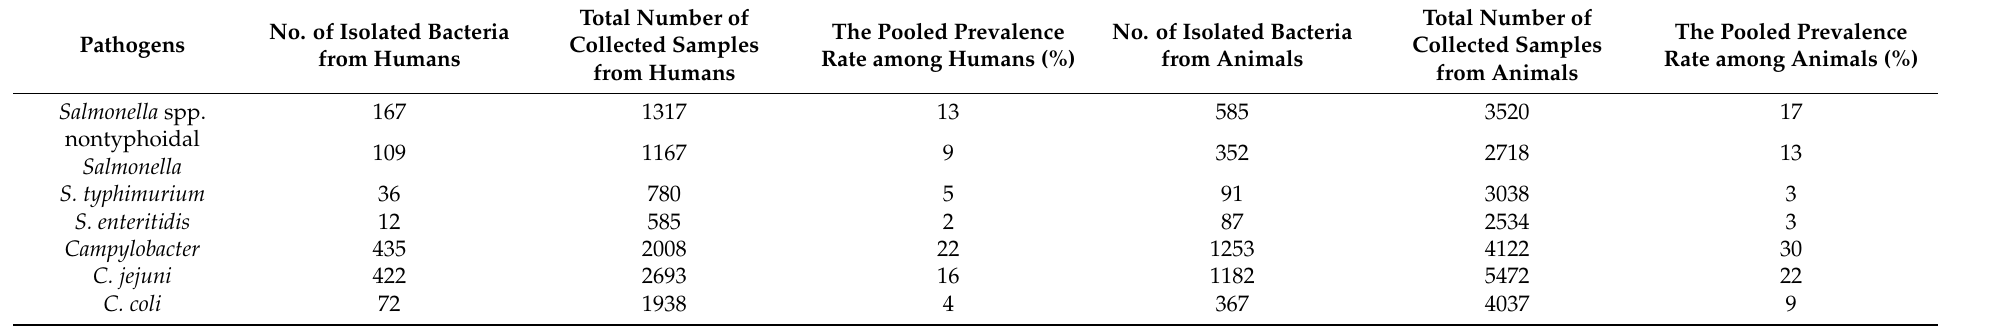
Table 1. Overall prevalence of Salmonella and Campylobacter and main serotypes.